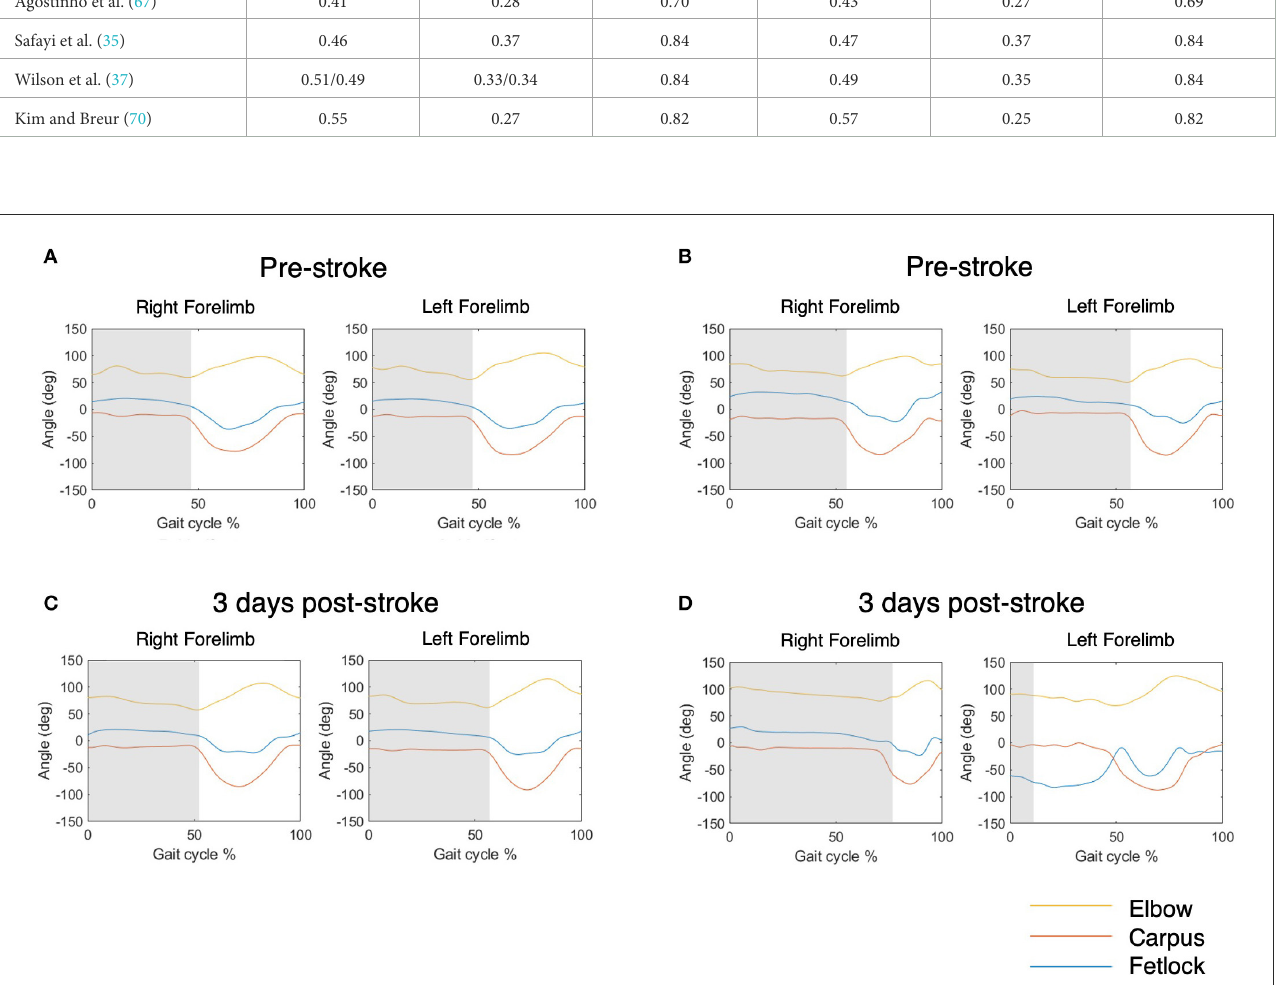
FIGURE5 Exemplar elbow, carpus and fetlock joint angle data over 0–100% of the gait cycle for two animals. Shaded grey indicates the stance phase. (A, B) Show joint angles pre stroke and (C, D) show joint angles 3 days following stroke. (A, C) This animal did not display significant change of the fetlock joint angle pattern following stroke, as identified by the blue line in the left forefoot. (B, D) In comparison, this animal displayed significant fetlock dysfunction, with a decreased left fetlock angle throughout the cycle and a reduction of left stance